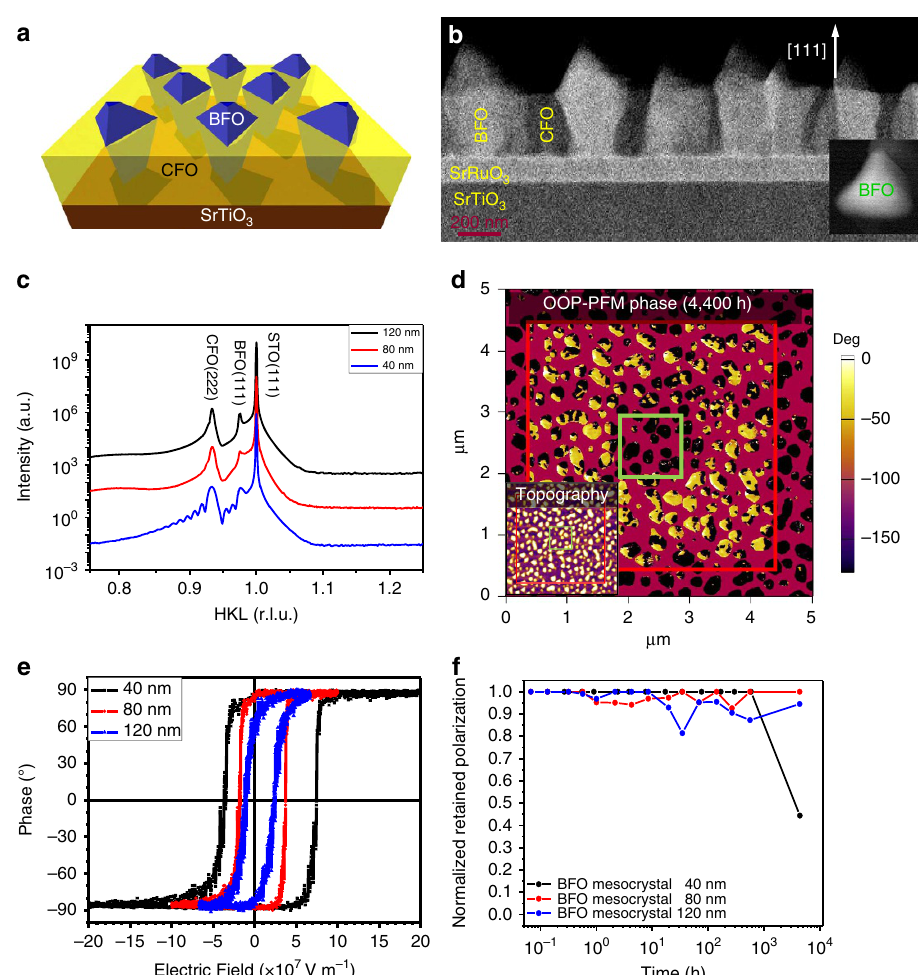
Figure 2 | The fabrication/design of BFO(111) mesocrystal structure and the observation of retention behaviour. ( a ) The schematic of BFO(111) mesocrystal. ( b ) The plane view of single BFO(111) nanocrystal and the cross-sectional TEM view of BFO(111) mesocrystals embedded in a CFO matrix. ( c ) High-resolution X-ray diffraction y –2 y scans around the STO(111) series of peaks. ( d ) The images of topology and corresponding OOP PFM recorded after switching 4,400h, respectively. ( e ) Phase–voltage hysteresis loops of different sample thickness. ( f ) Comparison of normalized retained polarization versus the relaxing time among reversed domains switched in BFO mesocrystal of different polarization. Thus, the phase–voltage hysteresis loops were measured through a Asylum Research Cypher S (ref. 38)